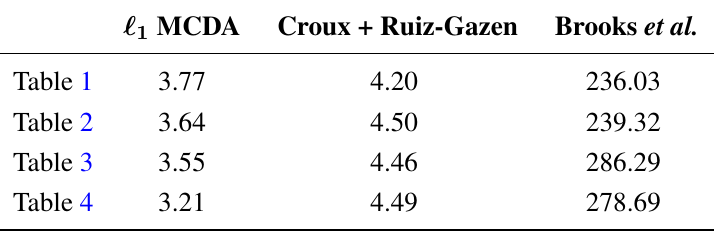
Table 5. Average computational times (in seconds) to generate the results in Tables 1–4 for n = 10 .